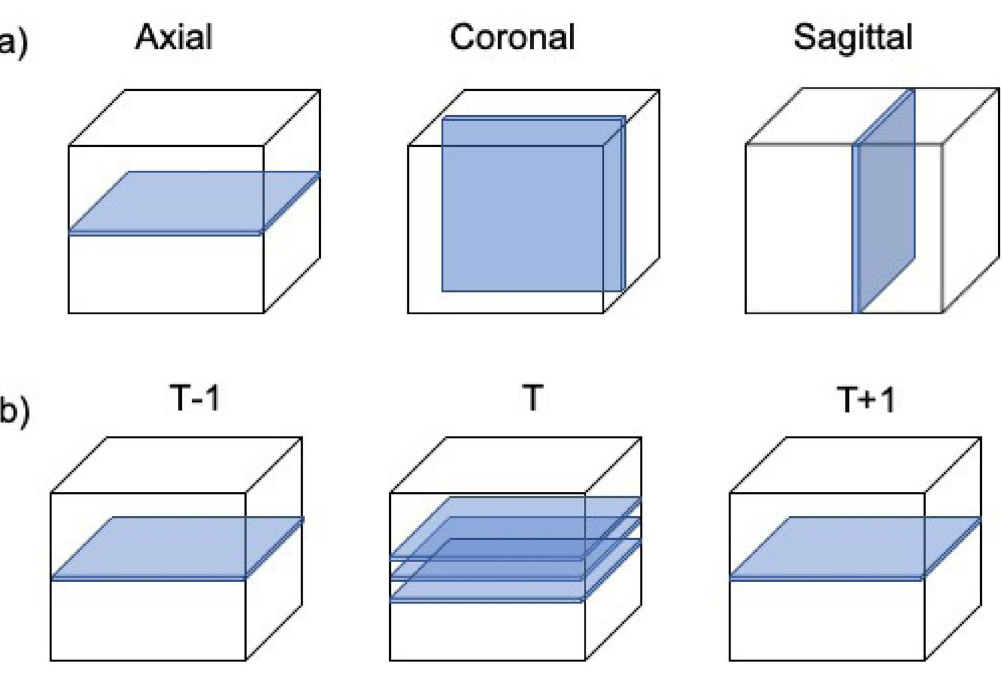
Figure 1. Schematic illustration of the training schemes. ( a ) Axial, coronal and sagittal views of the sample. The axial view is used during standard training. For the ensemble training, all three views are individually